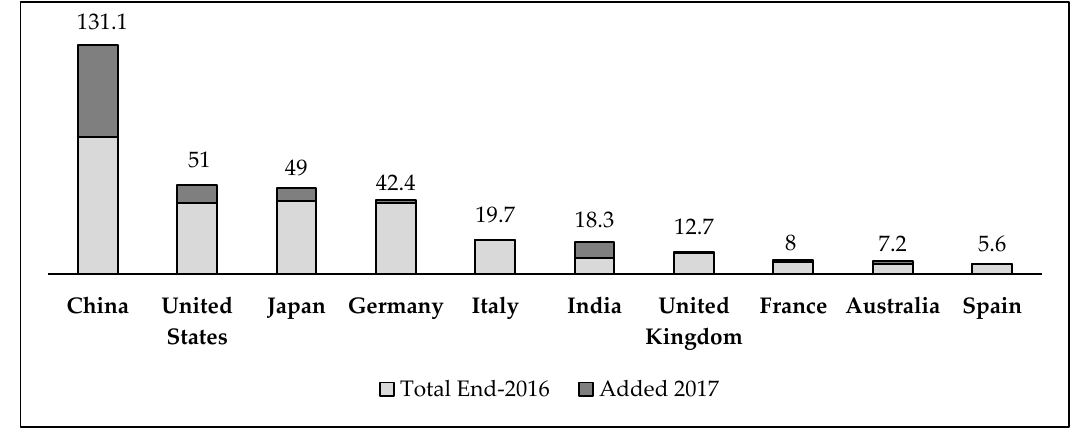
Figure 2. Cumulative solar PV power capacity in 2017. Data expressed in GW. Top 10 countries (REN21 2018).